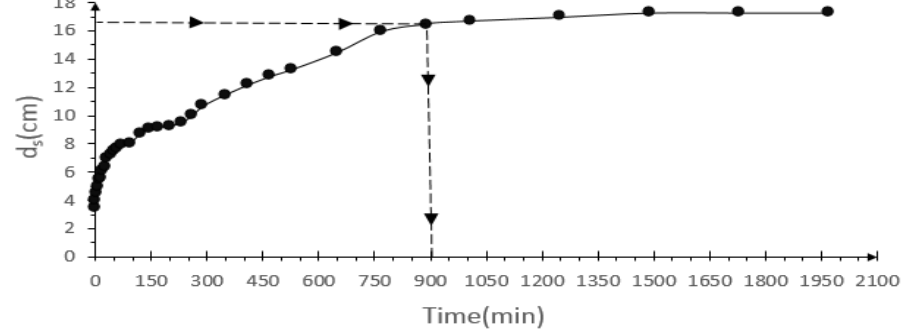
Figure 5. Variations of the maximum scour depth in time in the test on equilibrium